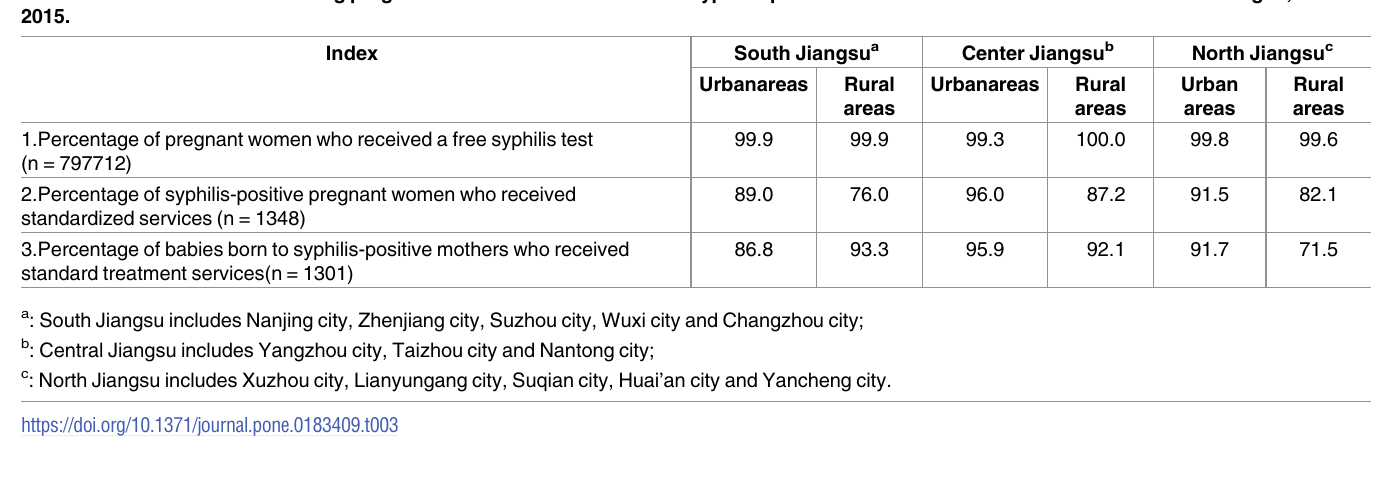
Urban areas Rural areas